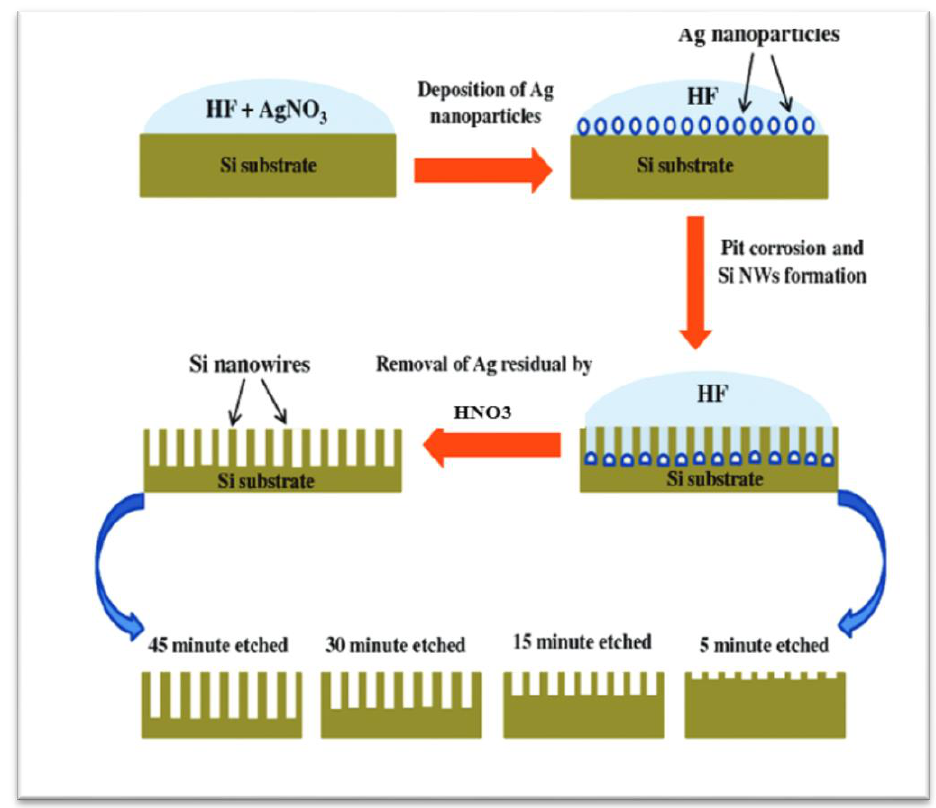
Figure 1: A diagram illustrating the production of NWs through metal-assisted chemical etching (MACE)